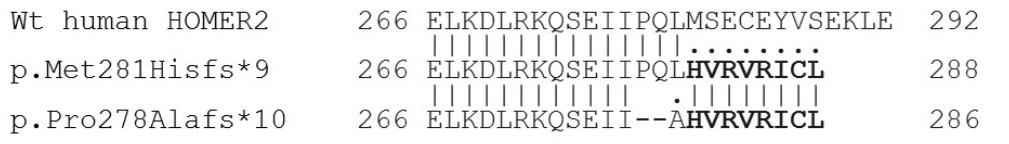
Figure 2. Alignment of the wild-type protein fragment encoded by exon 8 of HOMER2 long isoform (NP_955362.1) and the truncating mutations in the CDC42-binding domain (CBD) identified in the Chinese (p.Met281Hisfs*9) and Spanish (p.Pro278Alafs*10) families. The amino acid sequence shared between both aberrant protein tails is shown in bold face.